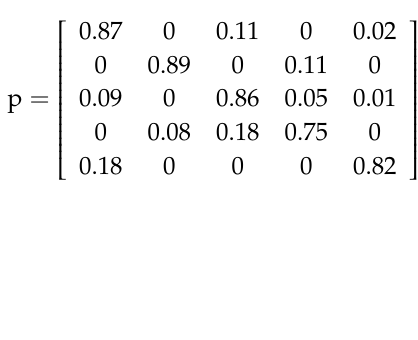
Figure 10. Data clustering of monitoring point 1.